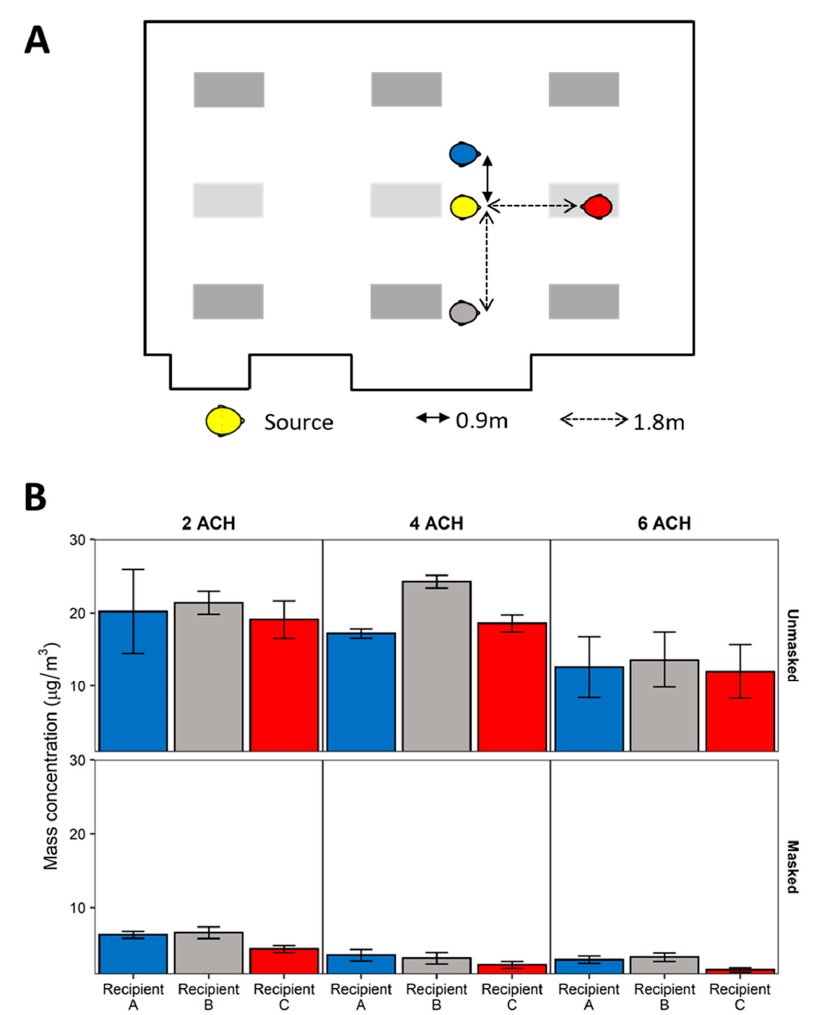
Figure 4. Effect of HVAC system ventilation. ( A ) Diagram of breathing simulator positioning for the experimental setup examining the effect of HVAC system ventilation. ( B ) Mean mass concentration measured at the Recipient breathing simulators for unmasked and universal masking experiments across the three HVAC system ventilation rates. Data are presented as the mean of four independent experiments. Error bars represent one standard deviation.